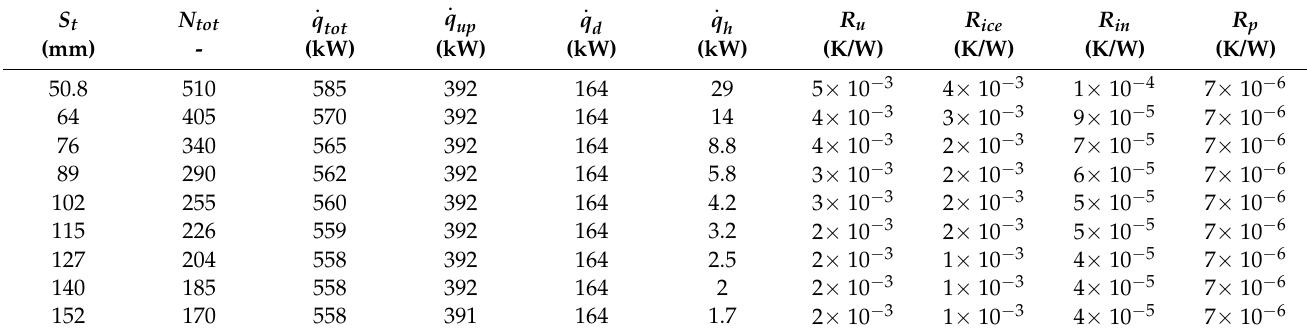
Table 1. Cooling capacity and thermal resistance change with the different tube pitches.